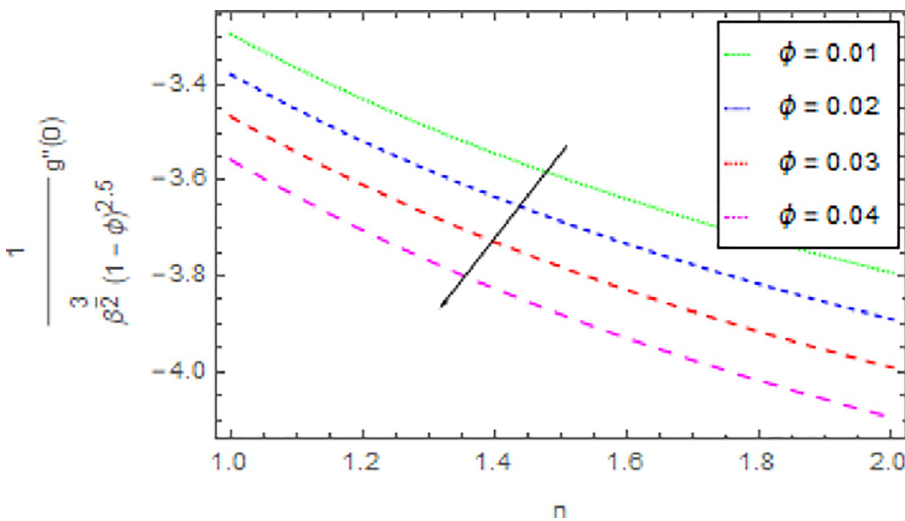
Fig 19. Deviation in skin friction coefficient of velocity ( y − direction) against ϕ and n when Pr = 1000, m = 0.10, M = 2.50, δ = 0.40, β = 1.00 and Nr =